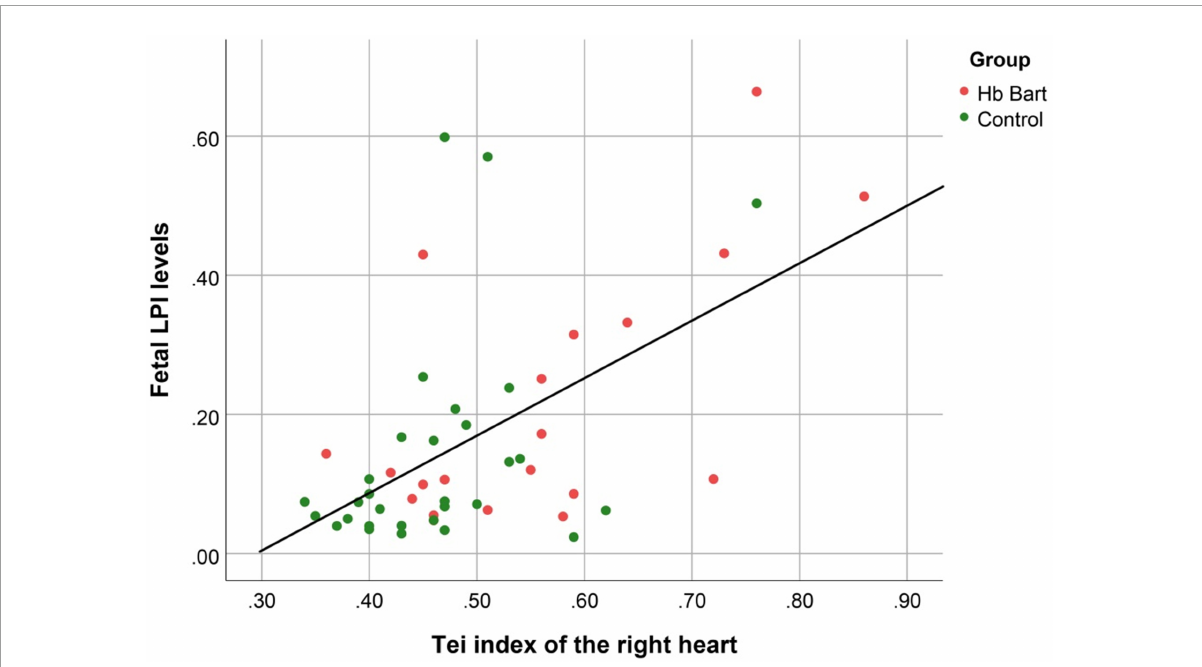
FIGURE3 The correlation between fetal LPI (Labile Plasma Iron) levels and fetal right myocardial performance index (Tei) (Linear function; R 2 : 0.326; p : < 0.001).